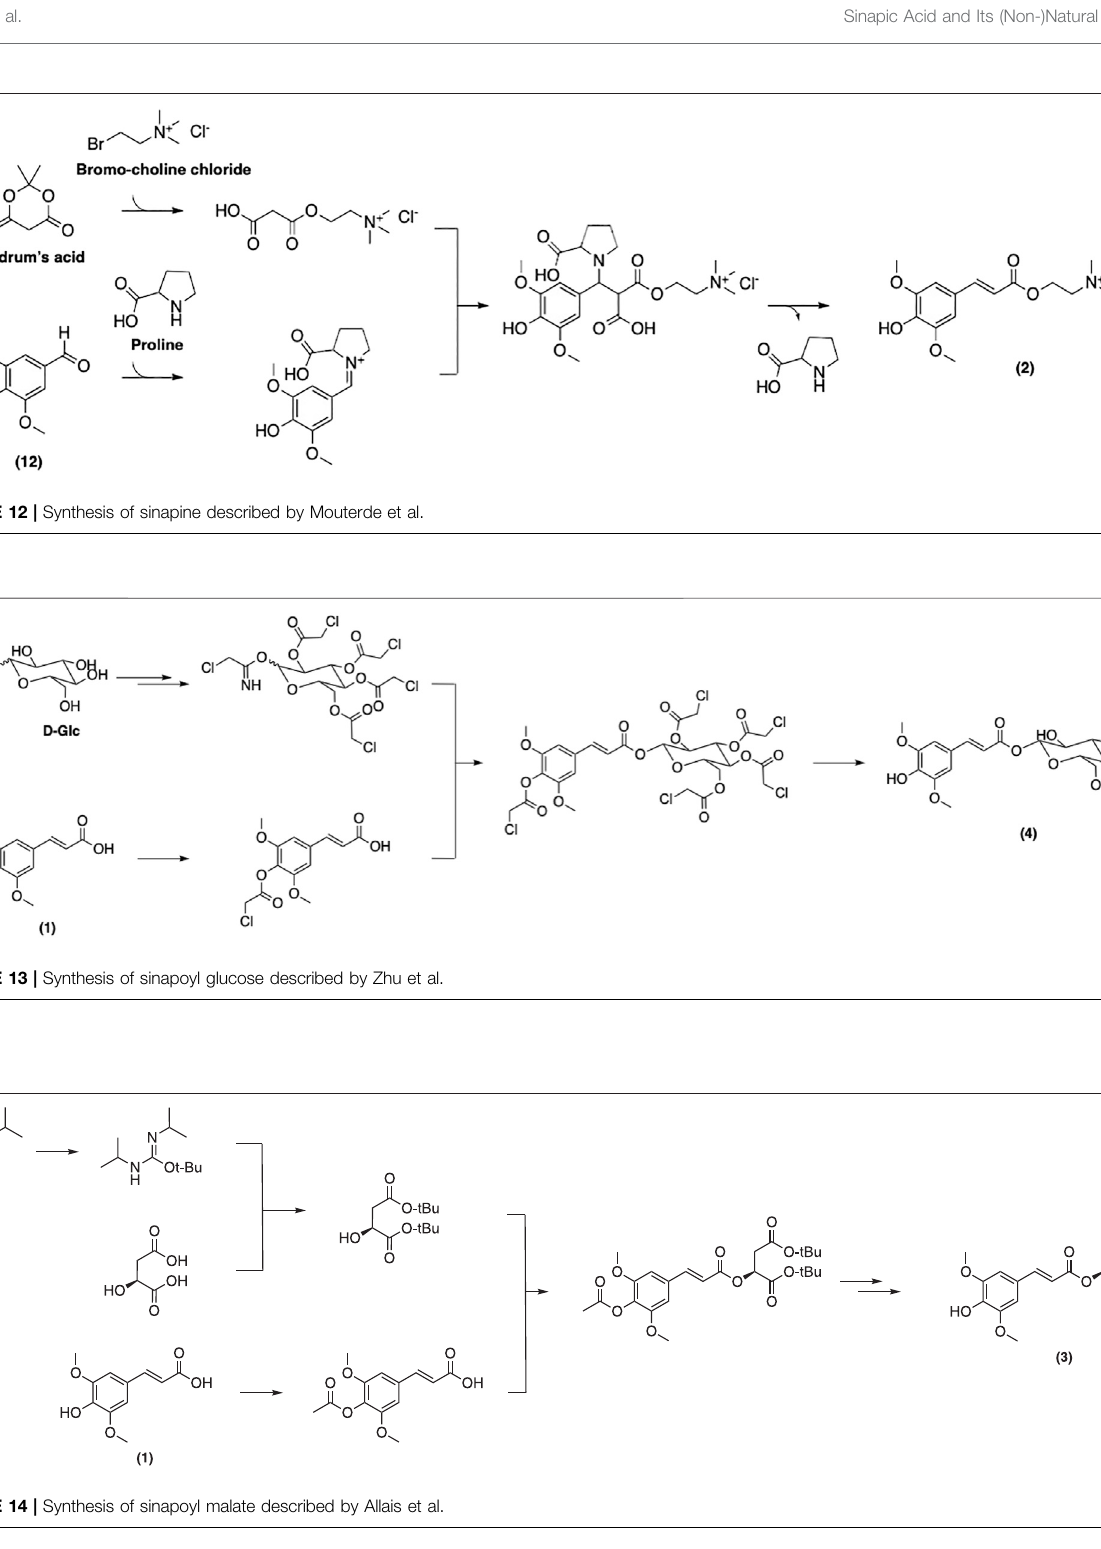
Frontiers in Chemistry |